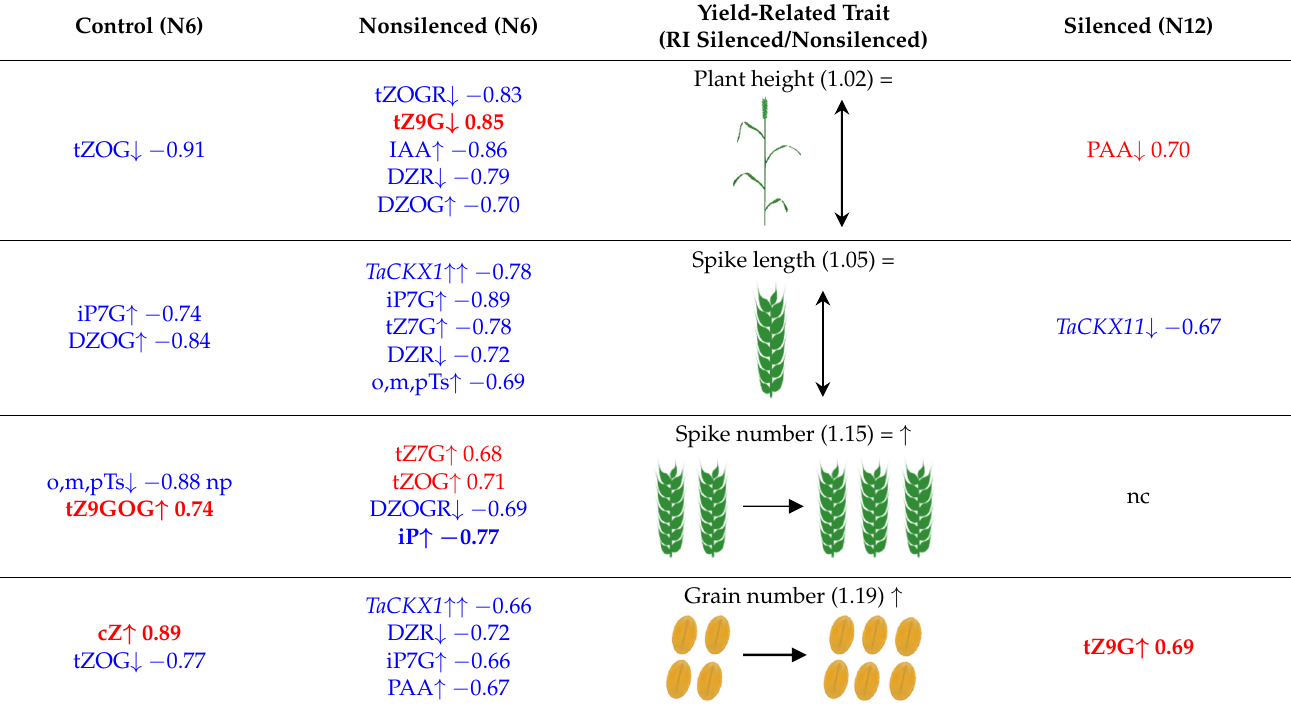
Table 1. Regulation of yield-related traits by TaCKX GFMs and phytohormones in groups of silenced TaCKX1 , nonsilenced and control plants based on correlation coefficients.